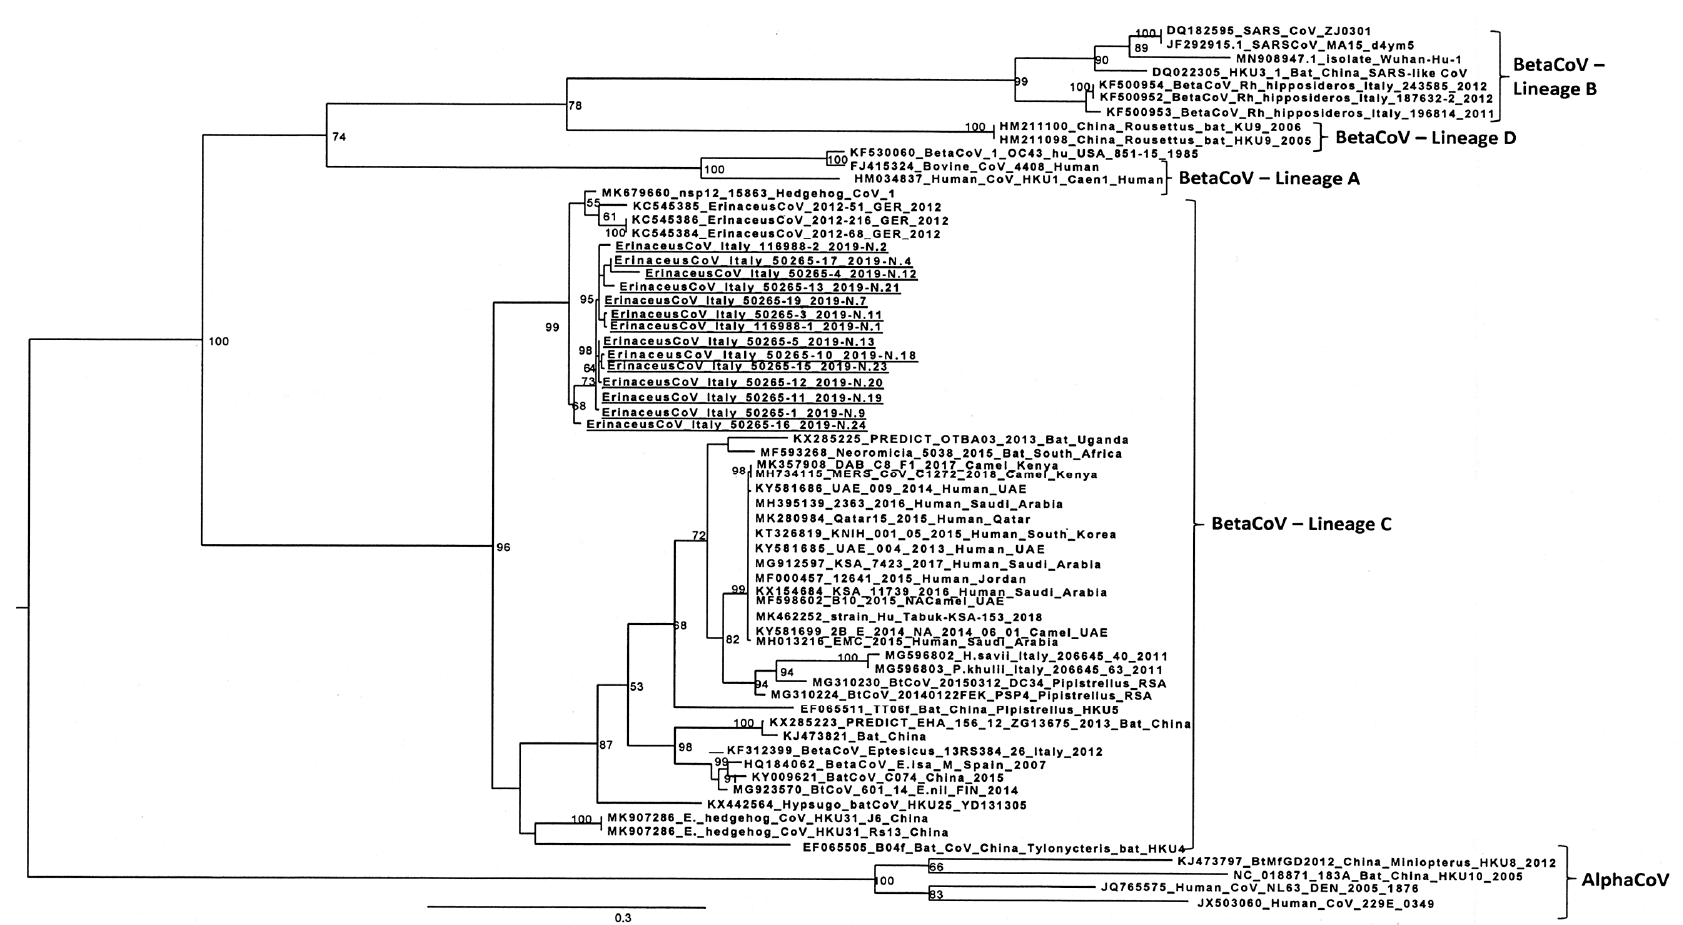
Figure 1. Maximum likelihood phylogenetic tree of lineage C betacoronaviruses, based on partial nucleotide sequences of the CoV RNA-dependent RNA polymerase gene. The EriCoVs detected in the present study are underlined (see Table 1 for details).